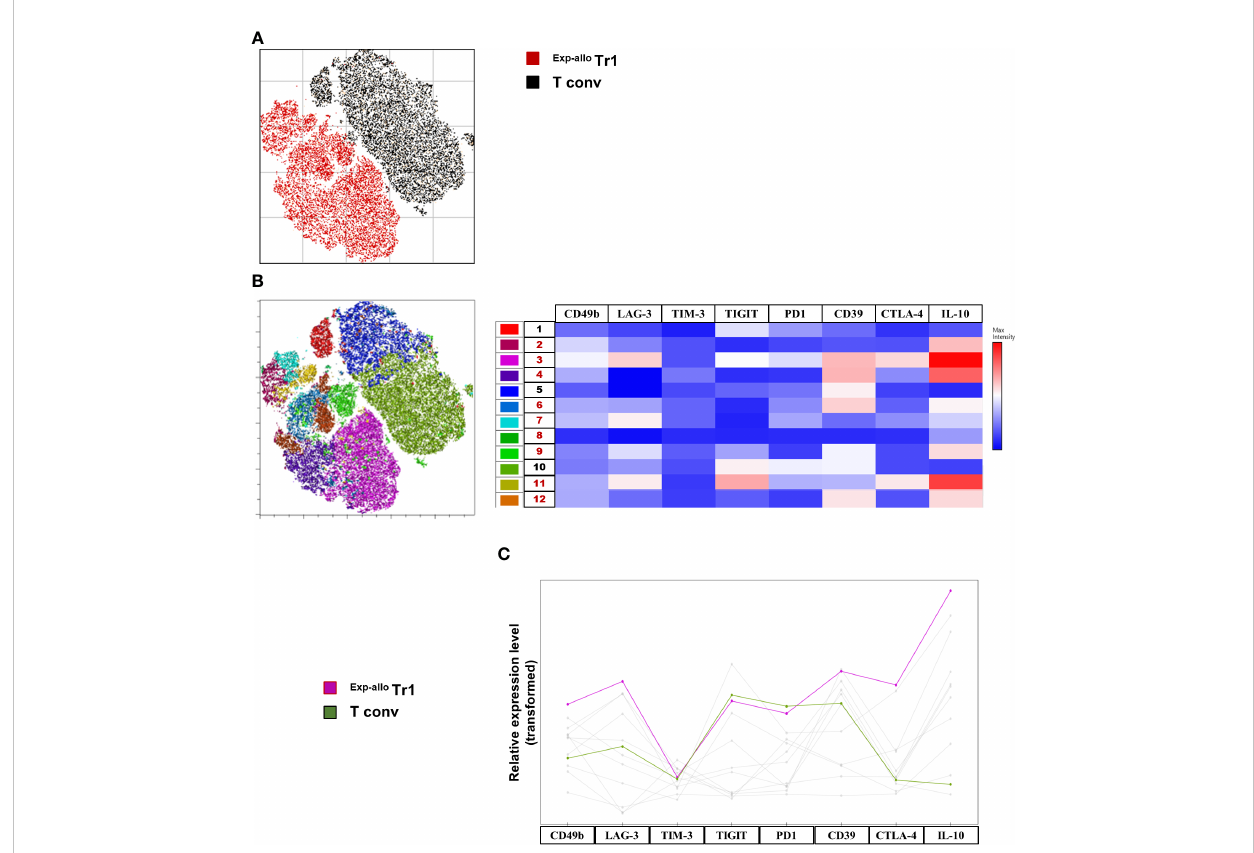
FIGURE 5 High dimensional analysis of Exp-allo Tr1 shows a differential expression pro fi le compared to T conv cells. Puri fi ed Allo Tr1 cells were polyclonally expanded for 21 days, co-inhibitory receptors were evaluated, and high dimensional analysis was used to further identify and explore their expression pro fi le. (A) Dimensionality reduction by Opt-SNE from live CD4 + Exp-allo Tr1 (n= 3) cells and T conv (n= 3) cells showed two major islands characterized by Tr1 (red) versus T conv (black) culturing conditions right panel). (B) X-Shift clustering analysis identi fi ed 11 clusters (excluding cluster 8, which represents 0.18% of the Tr1 population) corresponding to one major island composed of Exp-allo Tr1 (2, 3, 4, 6, 7, 9, 11 and 12) and the other with T conv (1, 5 and 10). The resulting heat map of median fl uorescence expression from each cluster shows a distinct expression pro fi le between Exp-allo Tr1 and T conv clusters. Clusters 3 and 10 were selected as representative of each culturing conditions clearly showing overexpression IL-10, CD39, LAG-3 and CTLA-4 wherein T conv were relatively low expressors for all these markers compared to Exp-allo Tr1 (C) . Relative expression line graph of median fl uorescence intensity shows the level expression of each co-inhibitory molecule from the underlying most representative populations: Exp-allo Tr1 (pink) vs T conv (green). Data are representative of two independent